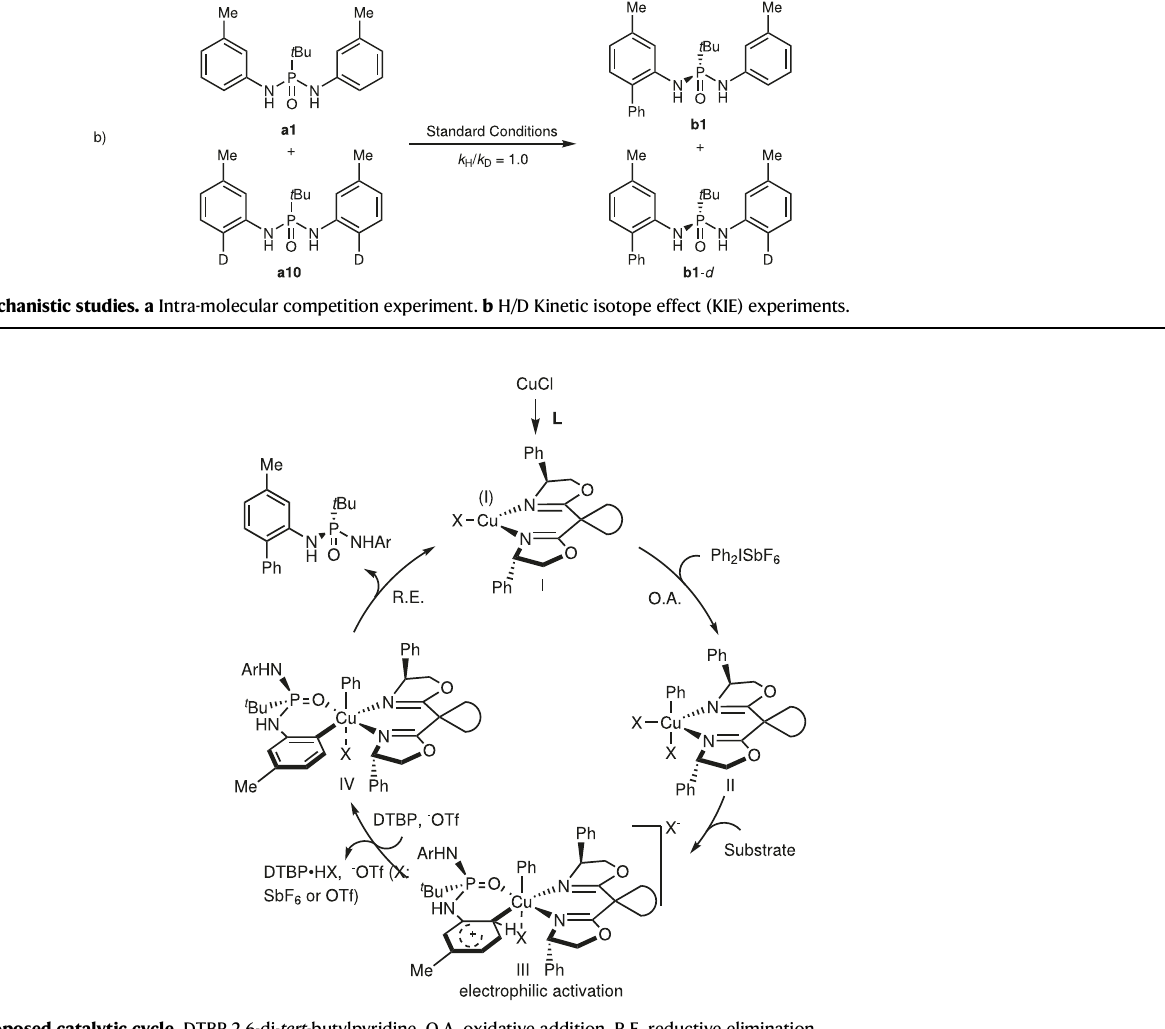
Fig. 8 | Proposed catalytic cycle. DTBP 2,6-di- tert -butylpyridine, O.A. oxidative addition, R.E. reductive